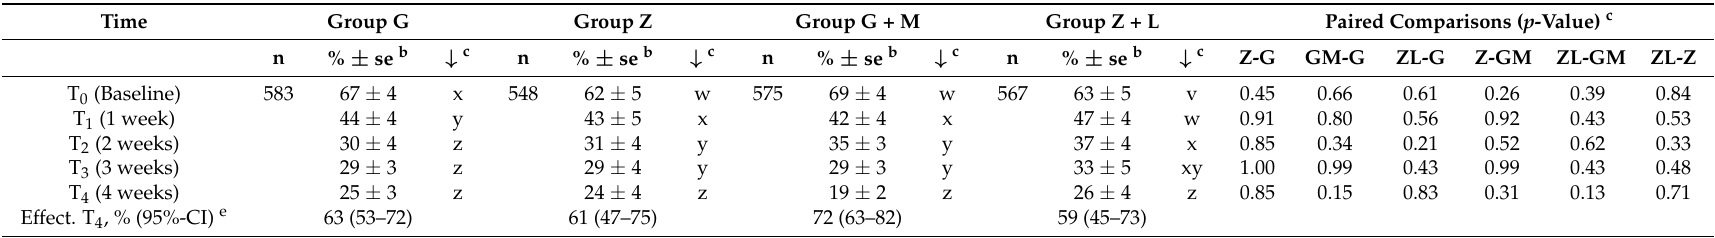
Table 2. Interproximal bleeding after IDB (interdental brush) according to treatment group in 2273 interproximal sites a (from 100 patients). Time Group G Group Z Group G + M Group Z + L Paired Comparisons ( p -Value)